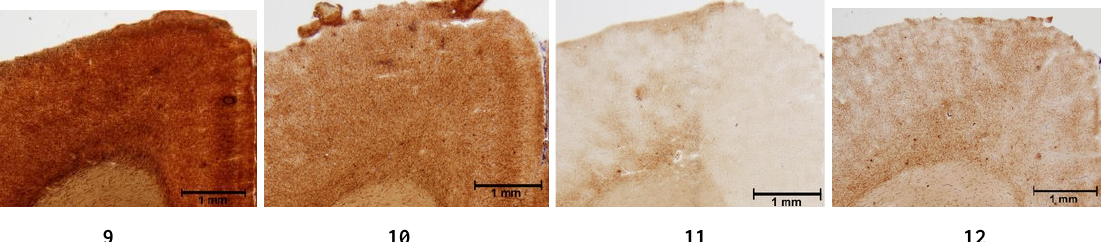
Figure 3. Top: Microphotography of 20 µ m sections of the rat brain (frontal cortex) following huperzine, soman and huperzine followed by soman administration.